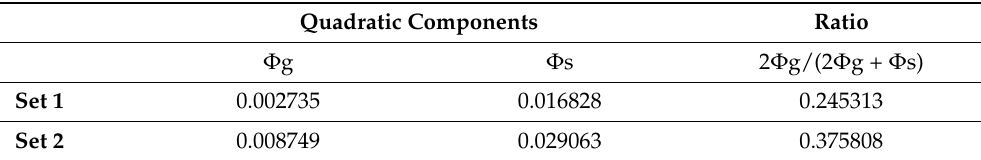
Table 8. Quadratic components of GCA ( Φ g) and SCA ( Φ s) for market yield and the Baker’s ratio [14] for Set 1 and 2.